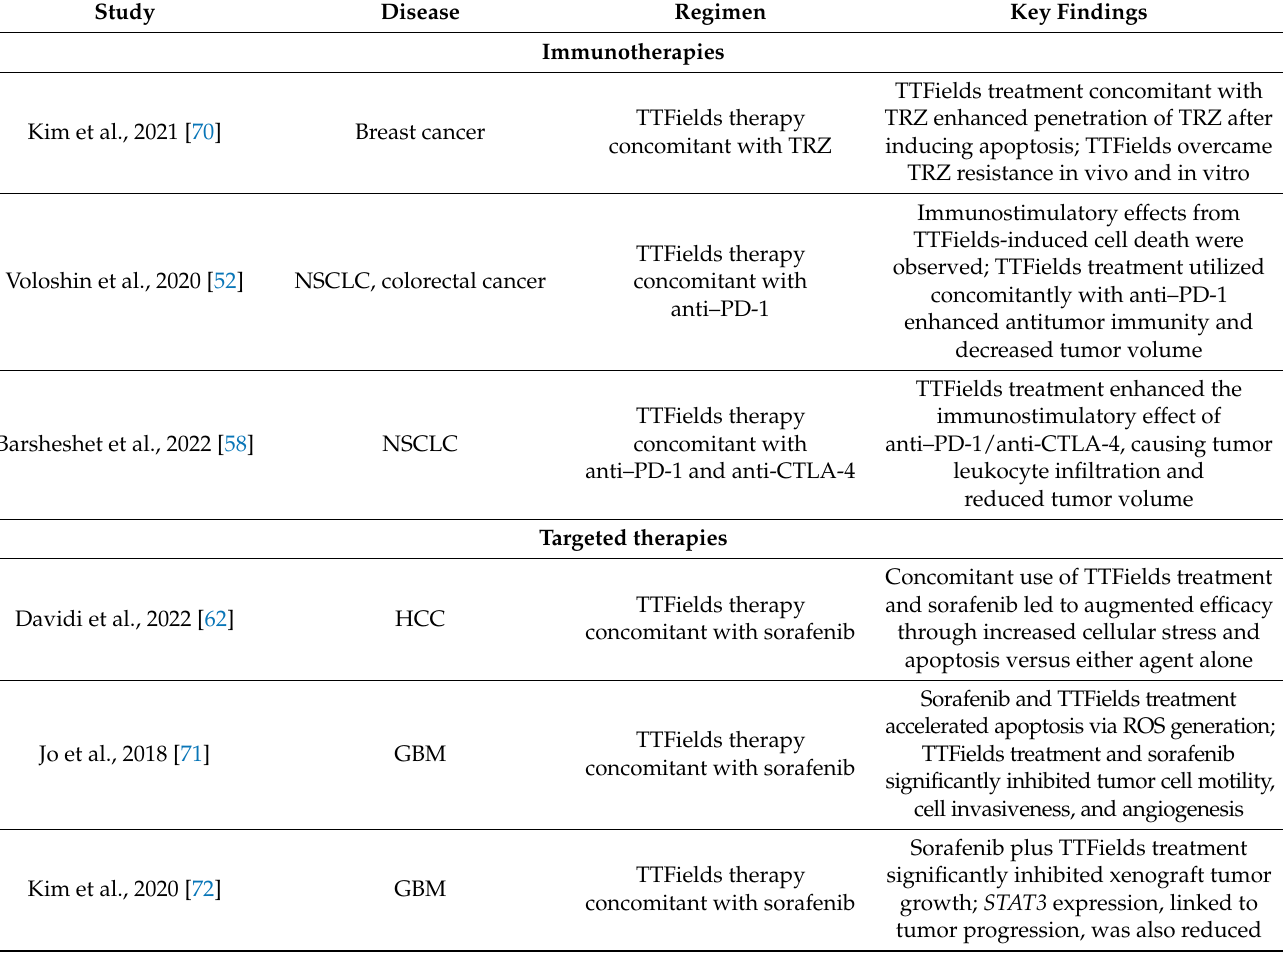
Table 2. A summary of preclinical studies investigating TTFields treatment concomitant with im- munotherapy or targeted